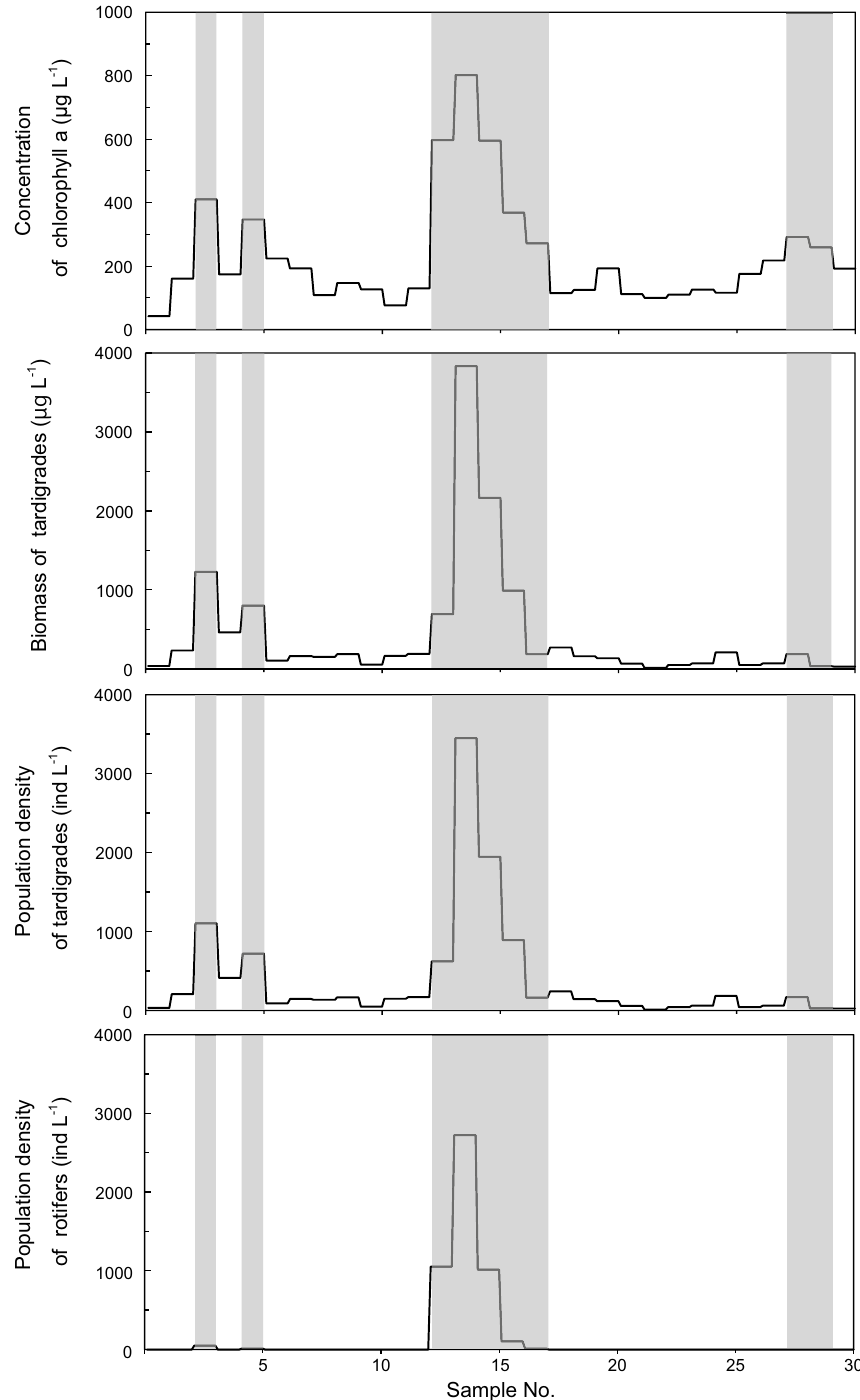
Figure 8. Concentration of chlorophyll a , calculated dry biomass of tardigrades and population density of tardigrades and rotifers per meltwater volume collected along a lateral line on snow surface in May 2019. Green snow is shown as gray